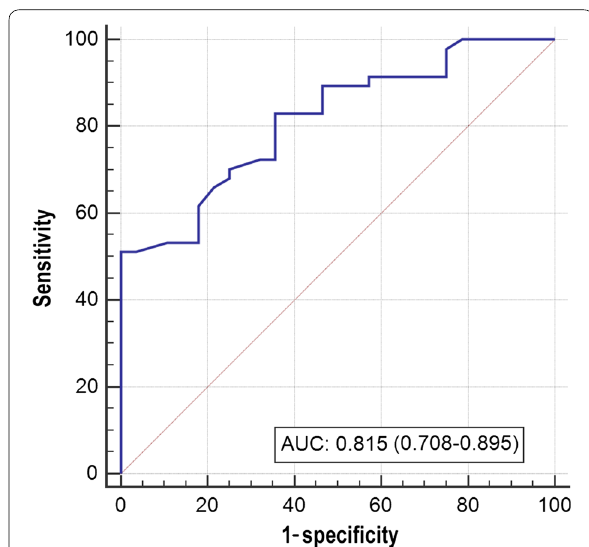
Fig. 4 Receiving operating characteristic (ROC) curve of short-axis diameter of metastatic lymph nodes measured on CT and/or MRI (the blue line). A cutoff value of 6.8 mm results in optimal sensitivity (83.0%) and specificity (64.3%) and high Youden index (47.3%). The area under the ROC curve (AUC) is 0.815, and 95% confidence interval is